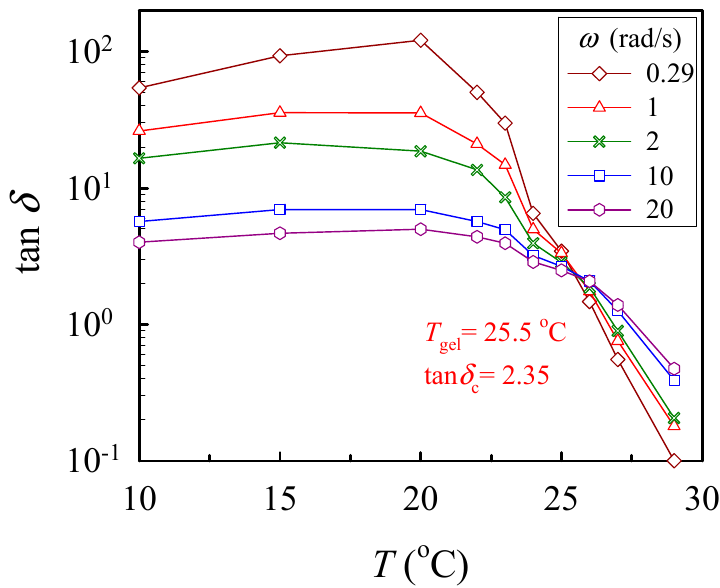
Figure 5. Plot of tan δ vs. temperature for the 10 wt% solution measured at different frequencies ω to determine the crossover point according to the Winter-Chambon criterion (Equation (2)).